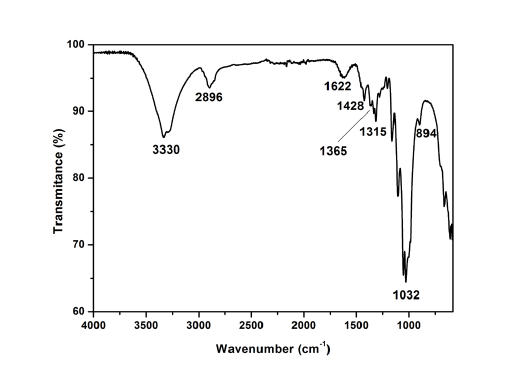
Figure 2. ATR-FTIR spectrum of the cotton